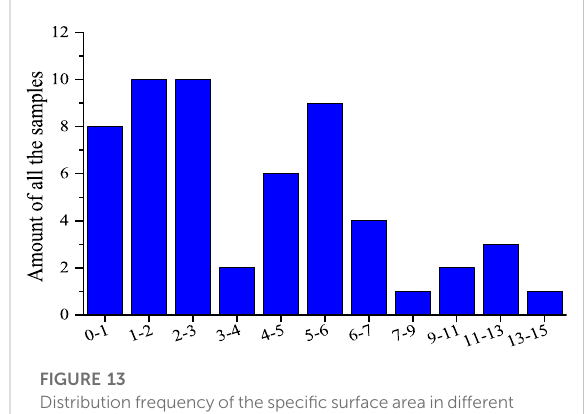
FIGURE 13 Distribution frequency ofthespeci fi csurfacearea indifferent intervals of the upper shale